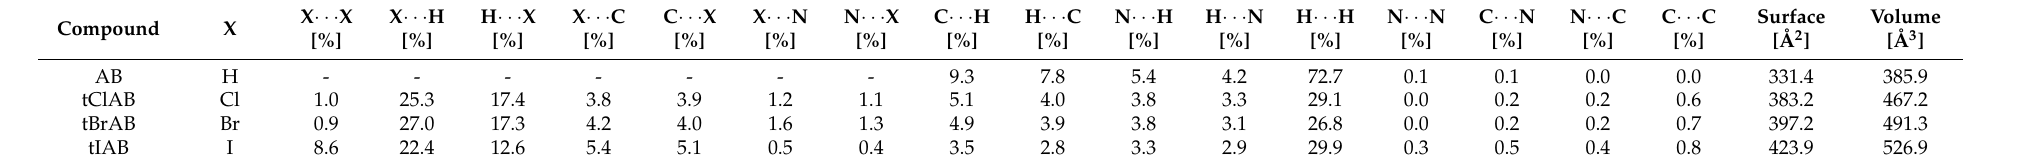
Table 5. A comparison of % of the Hirshfeld surface, total Hirshfeld surface and volume characterizing a set of compounds studied. Compound